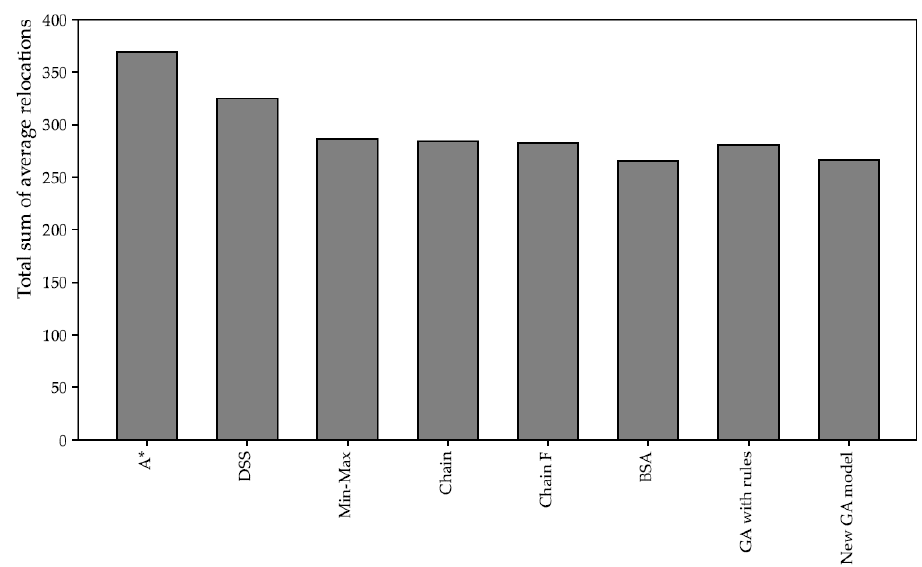
Figure 12. Total sum of average relocations for all test cases.